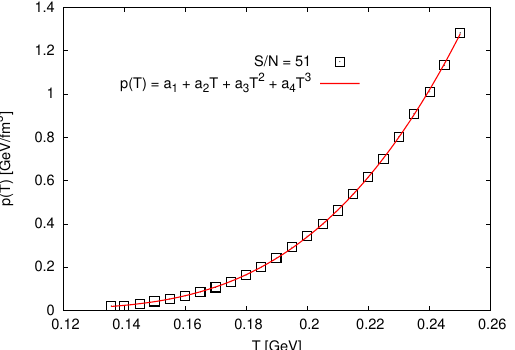
Figure 1. Pressure p is given in dependence on the temperature T . The symbols refer to lattice QCD simulations [22] and the solid curve stands for the proposed expression, Equation (9).